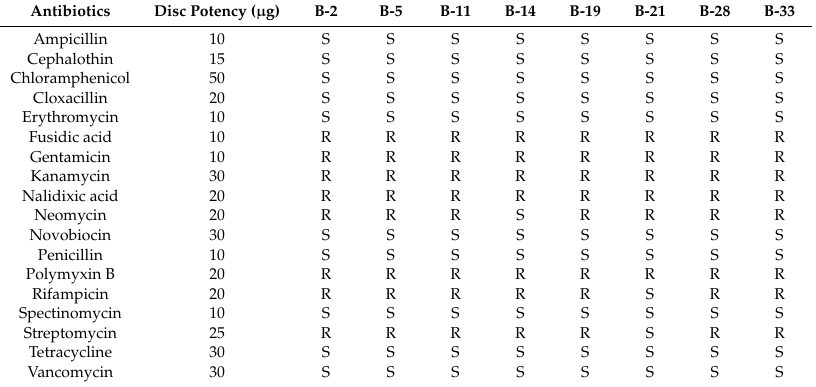
Table 4. Antibiotic susceptibility of isolates.